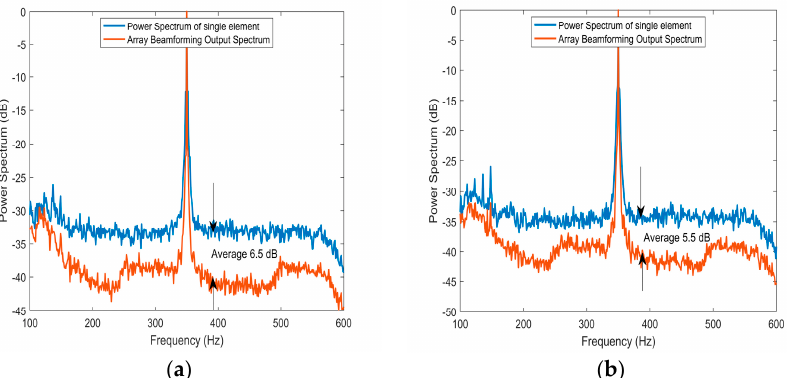
Figure 24. Average AGs in the shadow zone ( a ) data in the middle measurement period; ( b ) data in the late measurement period.